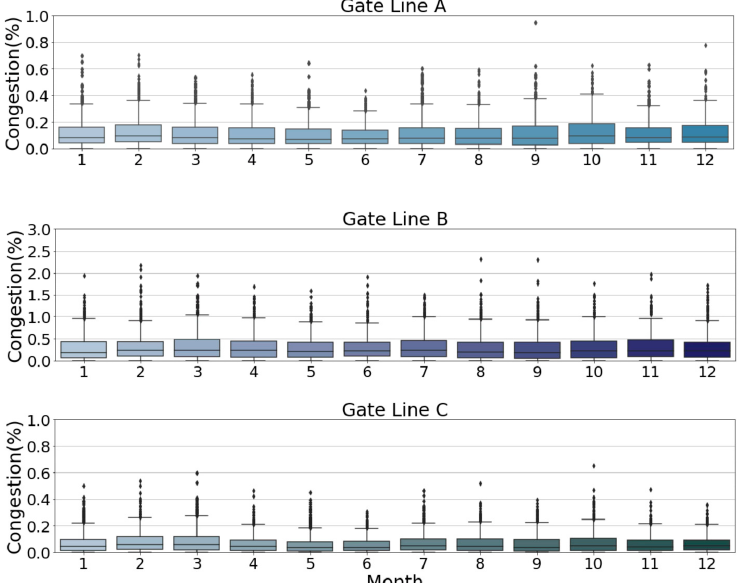
Figure 4. Results of maritime traffic congestion analysis by gate line (monthly).